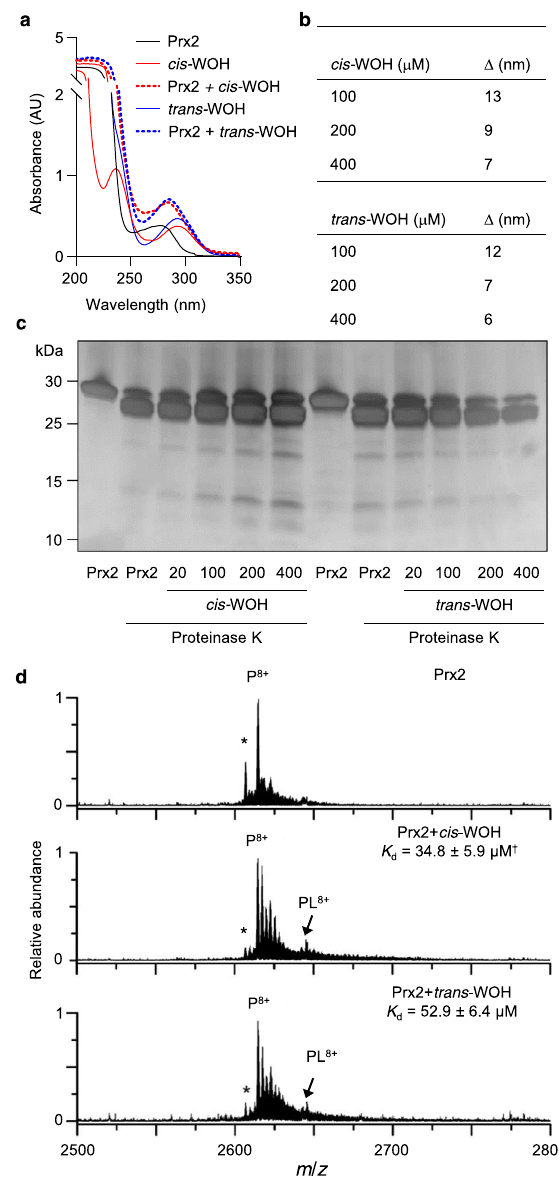
Fig. 5 Differential binding and dissociation of cis - and trans -WOH to and from Prx2. a Spectral shift analysis showed shifts from 277 nm (20 μ M His- tagged Prx2 alone) to 280 (Prx2 + cis -WOH) and 288 (Prx2 + trans -WOH) indicative of isomer differences in protein binding. b Representation of data from ( a ) as delta of maximum absorption wavelength of both alcohols (100, 200 and 400 μ M) in the presence of Prx2. c Silver staining following SDS- PAGE of samples reveals isomer-speci fi c difference in degradation patterns of proteinase K digested pre-reduced His-tagged Prx2 (20 μ M) after incubation with 20-400 μ M cis - or trans -WOH. d Nanoelectrospray ionization mass spectrum of aqueous solutions containing pre-reduced His- tagged Prx2 and cis - or trans -WOH at 1:1 molar ratio reveals a shift of Δ m / z of 27.5 indicating non-covalent ligand-protein bonding. The dissociation constants ( K d ) were obtained from the relative peak areas corresponding to unbound and ligand-bound protein ions reveal cis- WOH to have a higher af fi nity for Prx2 than trans -WOH. Traces/images are representative of 2 ( a ) or 3 ( c , d ) independent experiments. Data shown in ( b ) is mean of two independent experiments. K d values in ( d ) are given as mean ± SEM of three independent experiments. *Truncated form of Prx2 that is missing the fi rst amino acid. † p = 0.05 compared with K - value for trans -WOH (one- d tailed Mann – Whitney). Source data are provided as a Source data fi